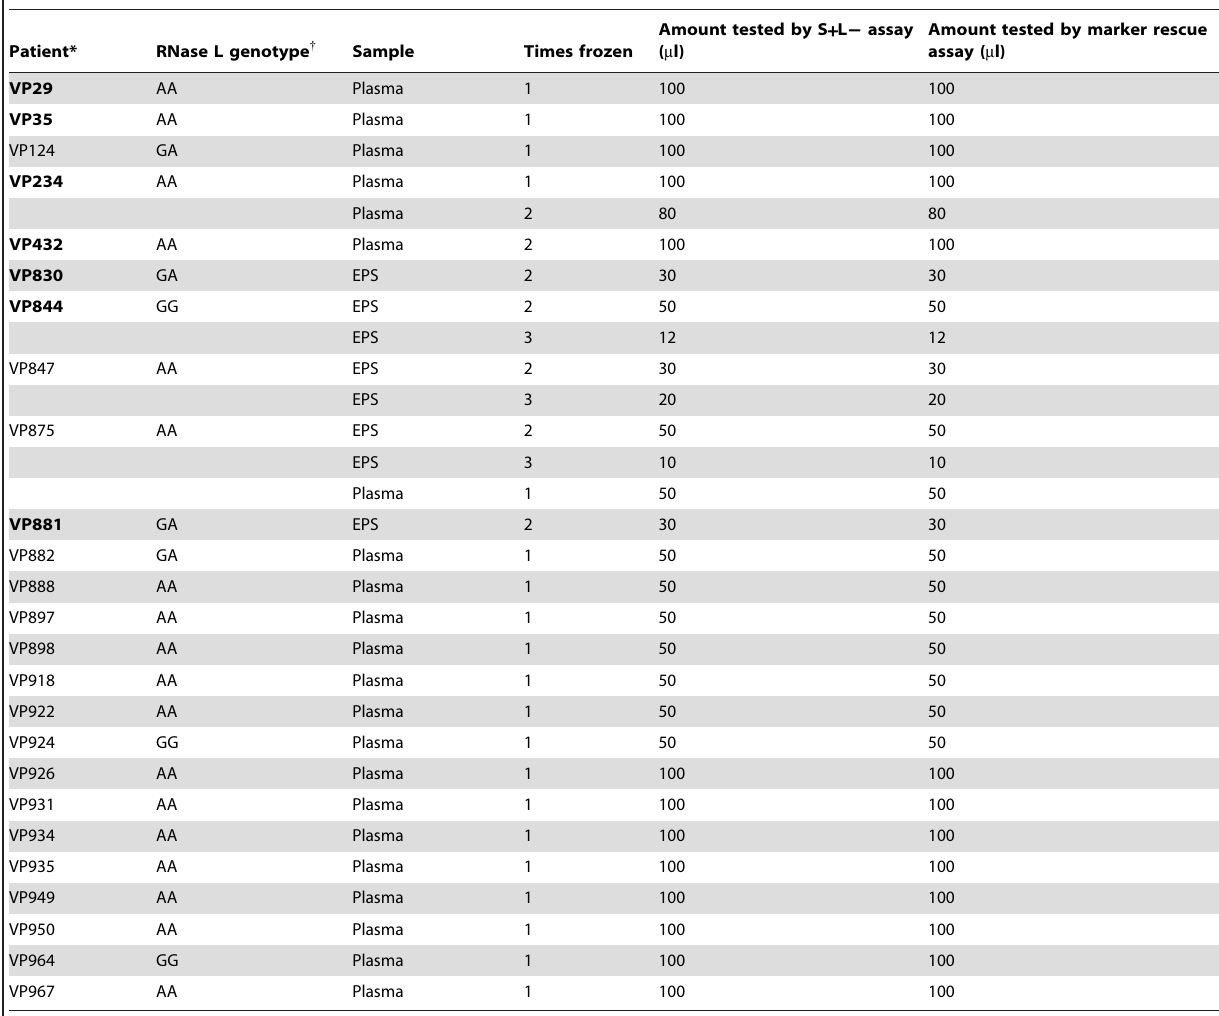
Table 2. Characteristics of plasma and EPS samples tested for infectious XMRV and related